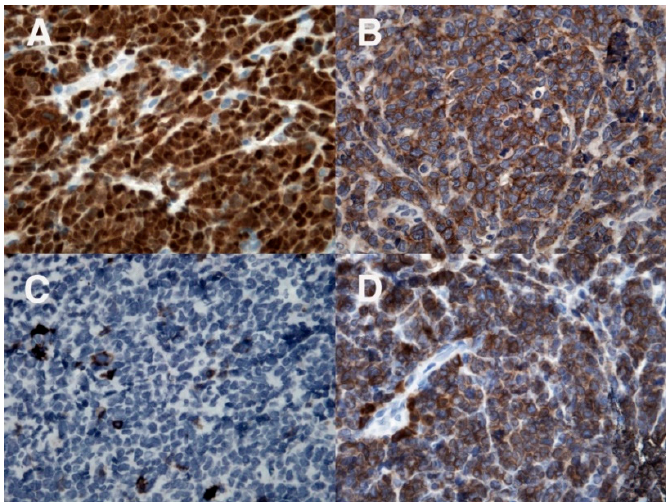
Figure 3. Immunohistochemical evaluation: positivity for TdT ( A ) and B-cell markers CD19 ( B ) and CD79a ( D ); CD20 ( C ) is negative.